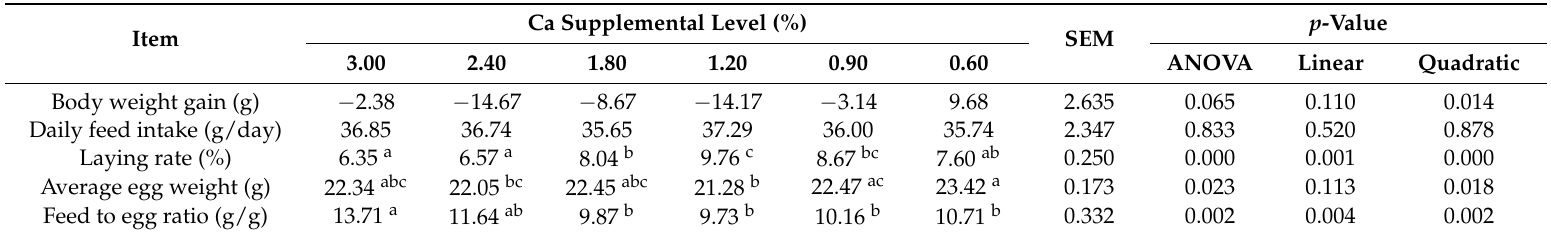
Table 2. The effect of dietary Ca level on performance of laying White King